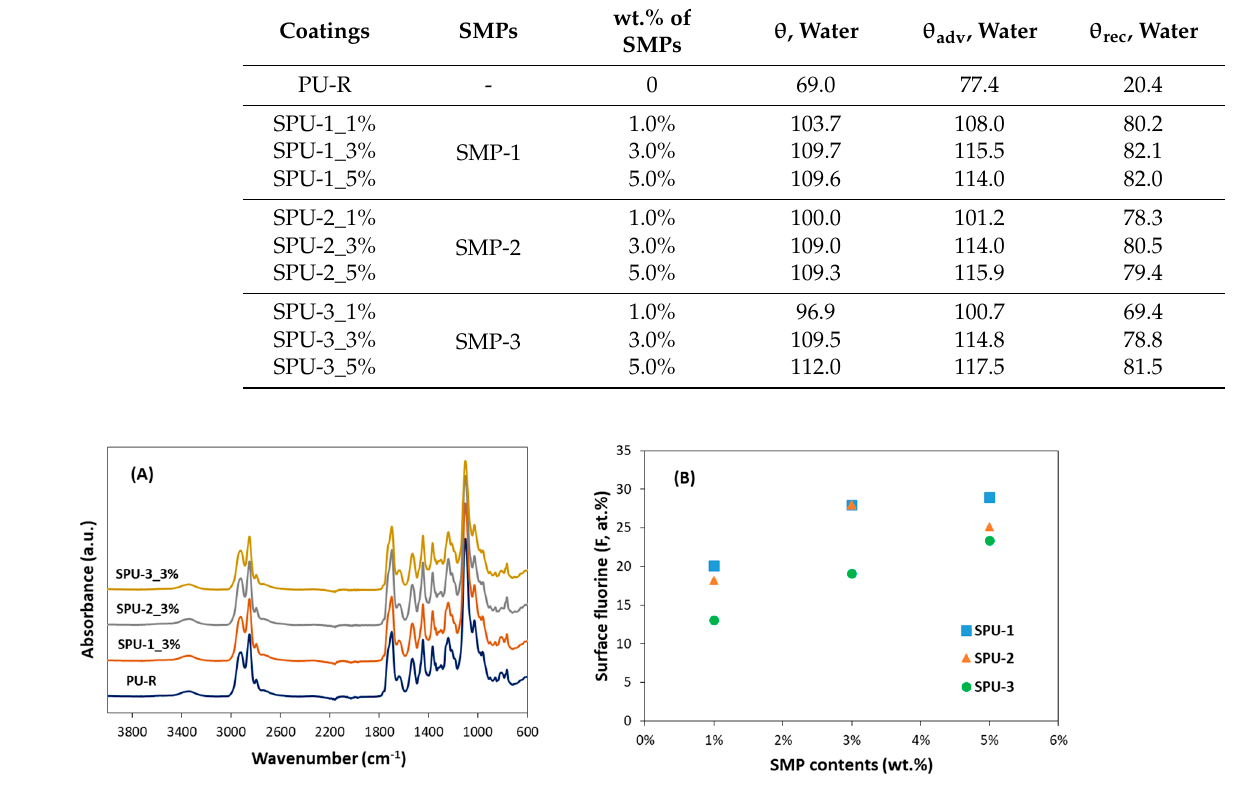
Figure 2. ( A ) FTIR spectra of PU-R and SPU coating films after curing at ambient conditions for 2 days, and ( B ) surface fluorine content (at.%) of SPU coatings from XPS studies. Table 2. Preparation and water contact angle measurements of SPU coatings.